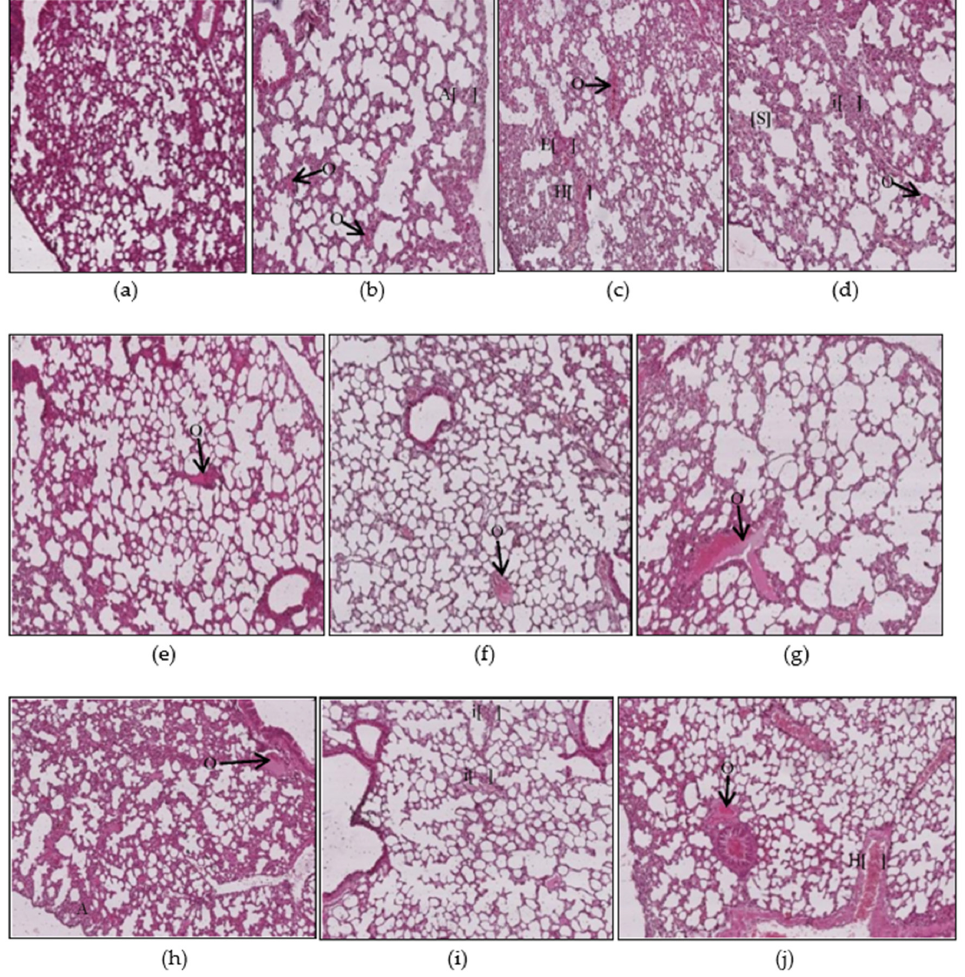
Figure 8. Histopathological photomicrographs (H&E, 400 × ) of lung tissues showing control ( a ),